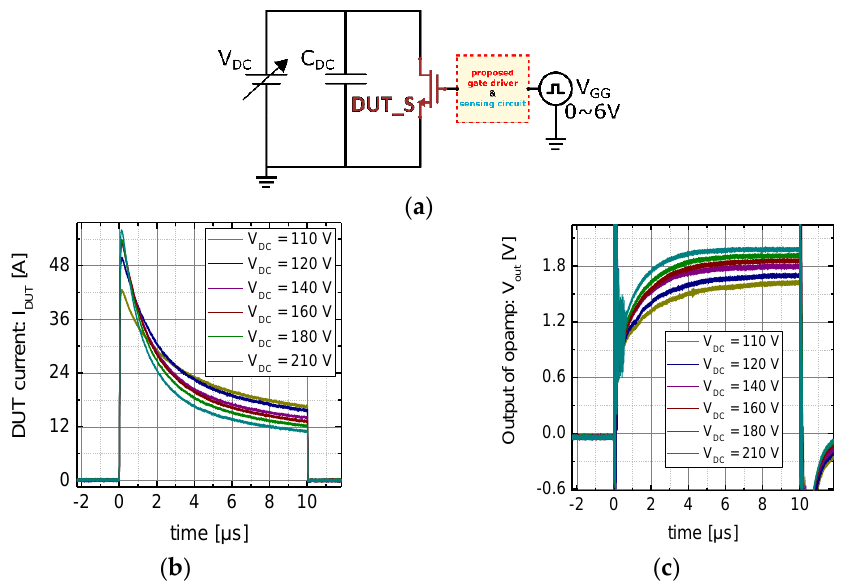
Figure 9. ( a ) Schematic representation of the setup for short circuit test and corresponding experi- mental waveforms of ( b ) the drain current through the DUT_S and ( c ) the output of the sensing circuit.